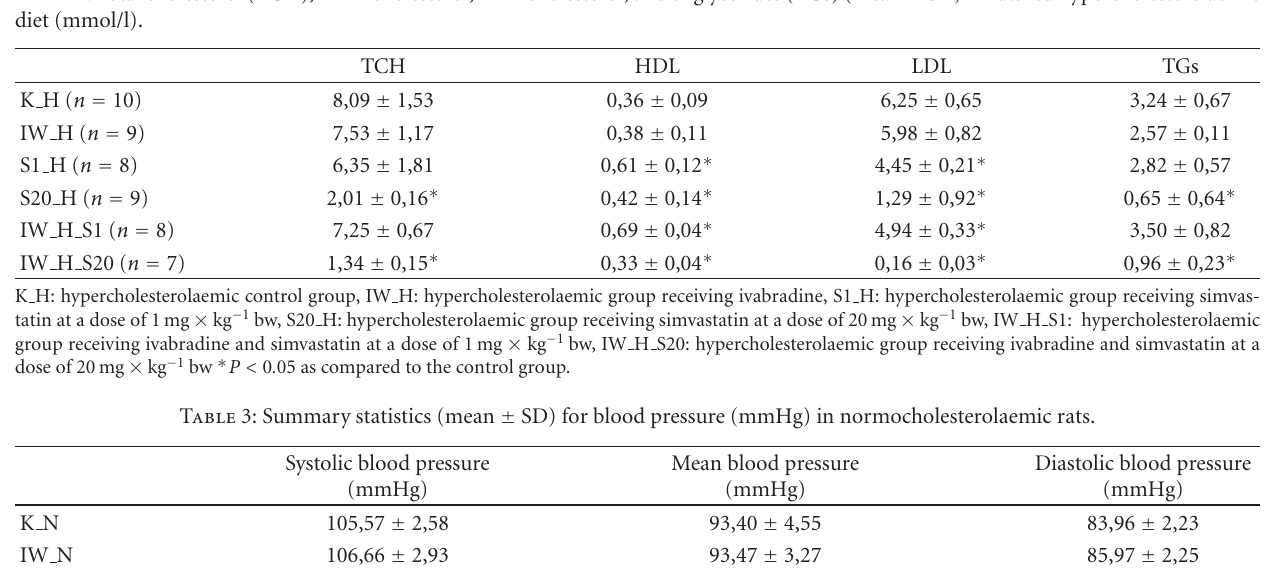
Diastolic blood pressure (mmHg)